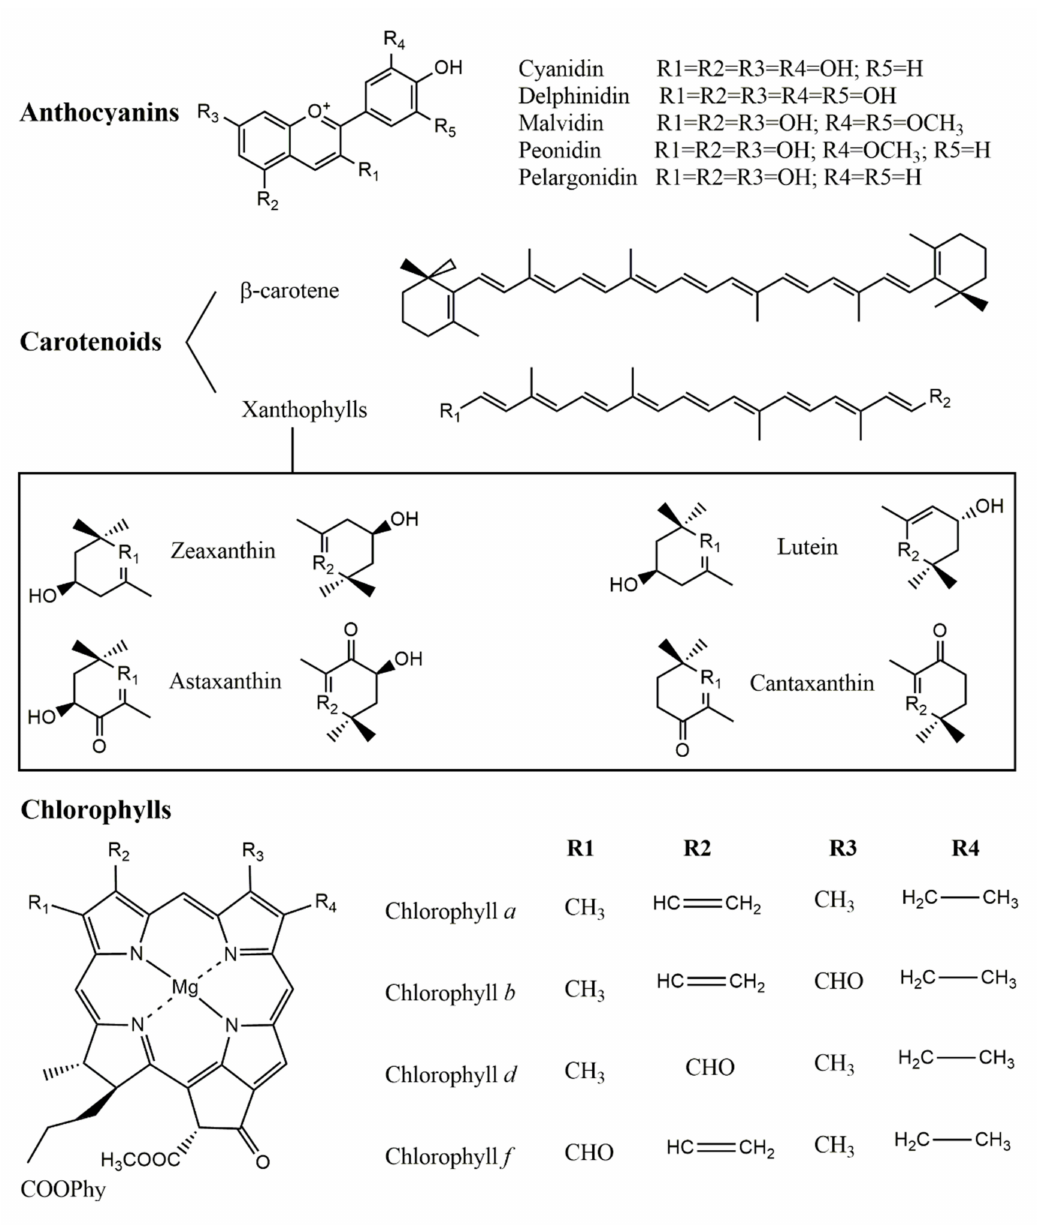
Figure 1. Chemical structures of the most commonly found pigments in plant